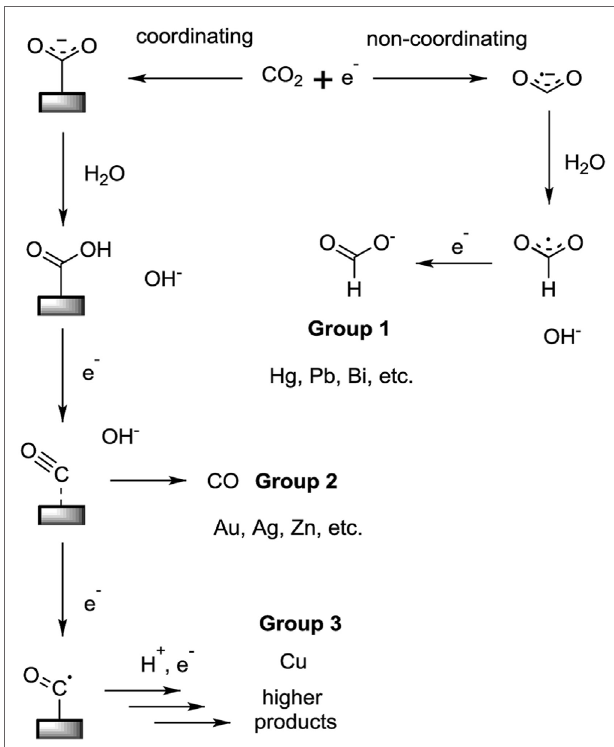
FiGURe 2 | Mechanism for electrochemical CO 2 reduction on metal surfaces in water (Jones et al., 2014)